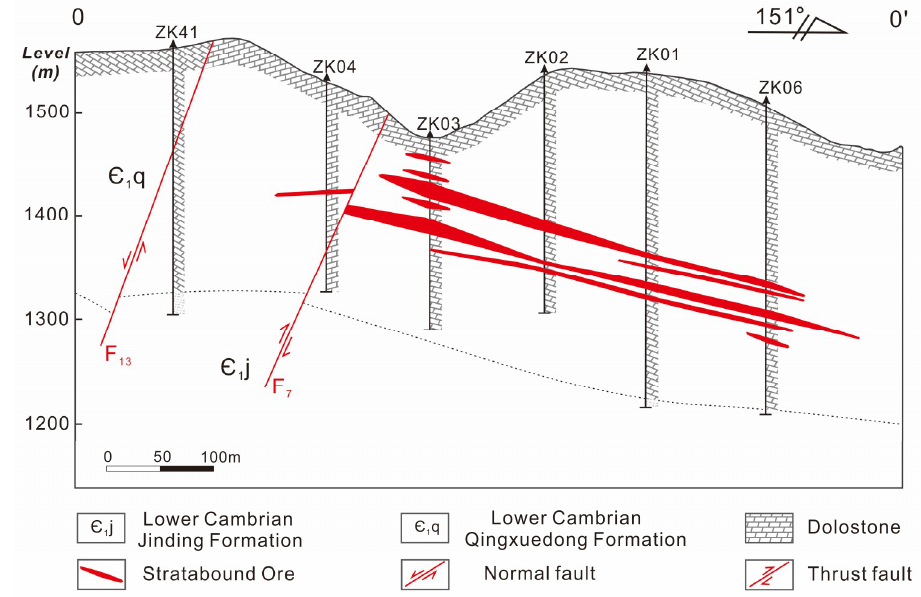
Figure 3. Geologic cross section 0-0′ through the Nayongzhi deposit, revealing the distribution of ore bodies, faults and strata (modified from Jin et al. [17]).